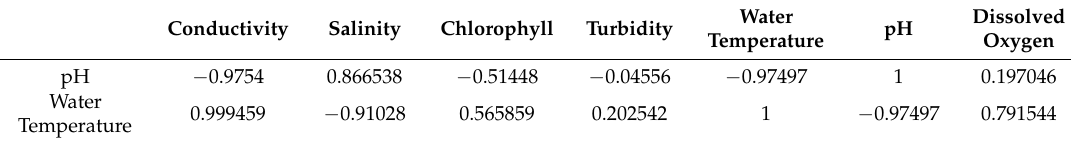
Table 1. Calculation results of